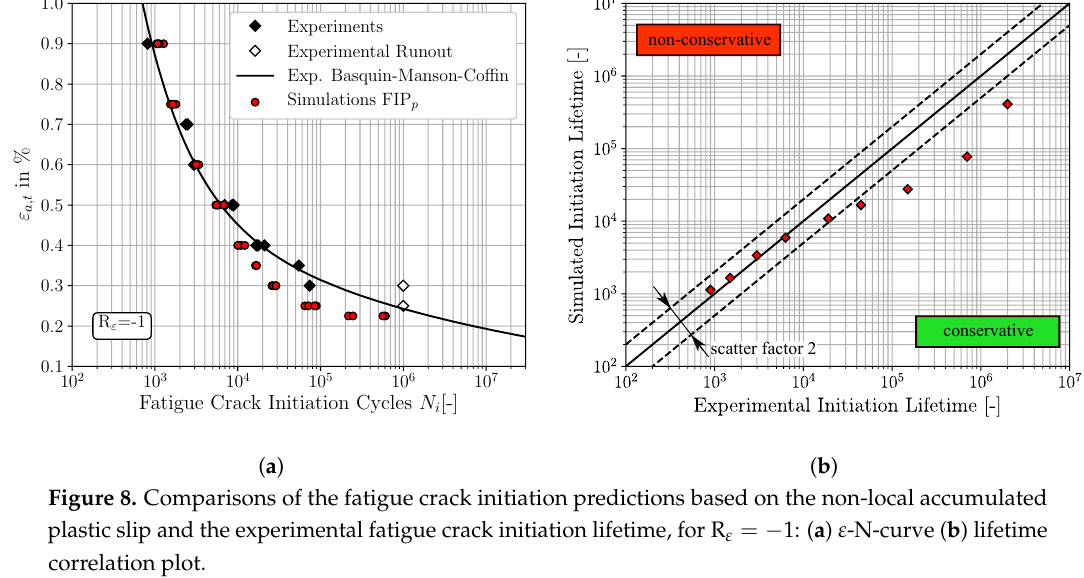
1: ( a ) ε -N-curve ( b ) lifetime −